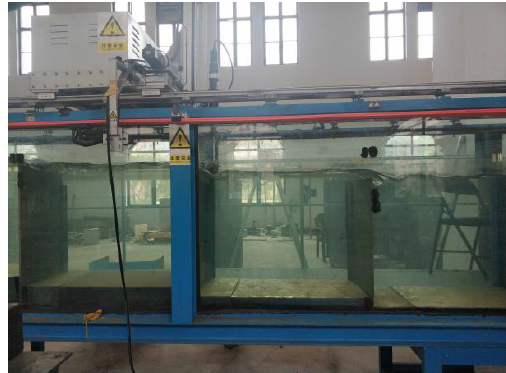
Figure 1. Setup of the flat-crested weir-type fishway flume.